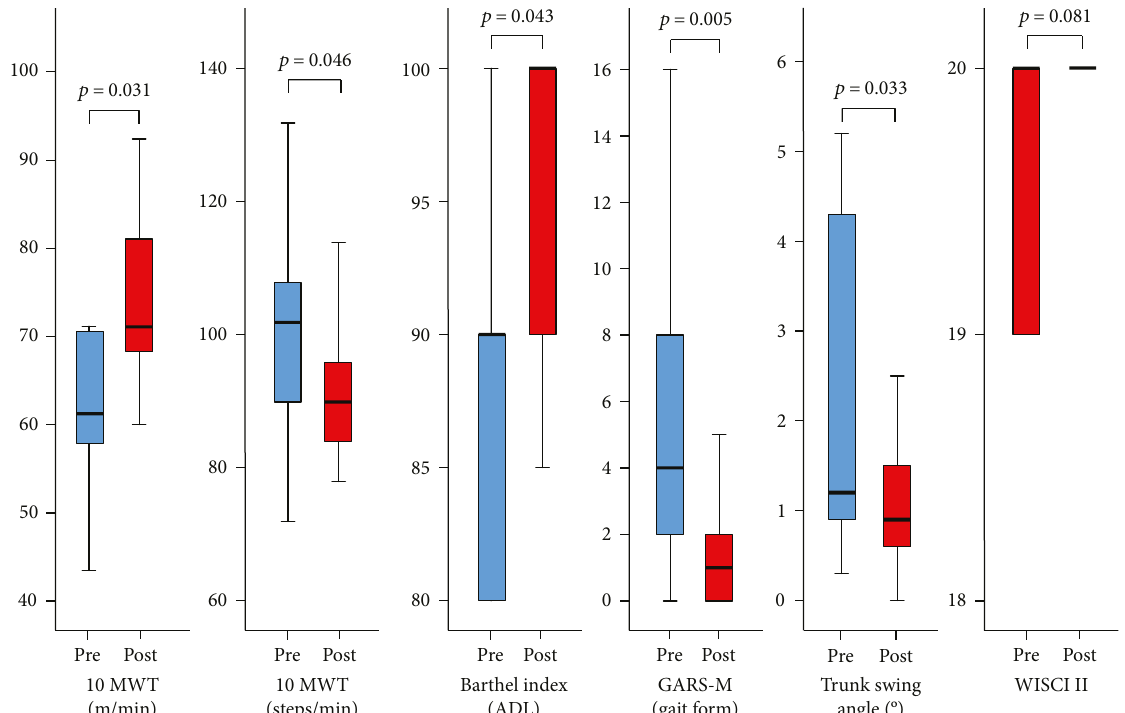
Figure 3: Graph showing functional outcomes evaluated by the 10-m walking test (10MWT): speed (m/min), cadence (steps/min), the Barthel Index, modi fi ed Gait Abnormality Rating Scale (GARS-M), trunk swing angle before and after Hybrid Assistive Limb (HAL) treatment, and the walking index for spinal cord injury II (WISCI II) score. Whiskers represent the standard deviation. Pre: before treatment; Post: after treatment.